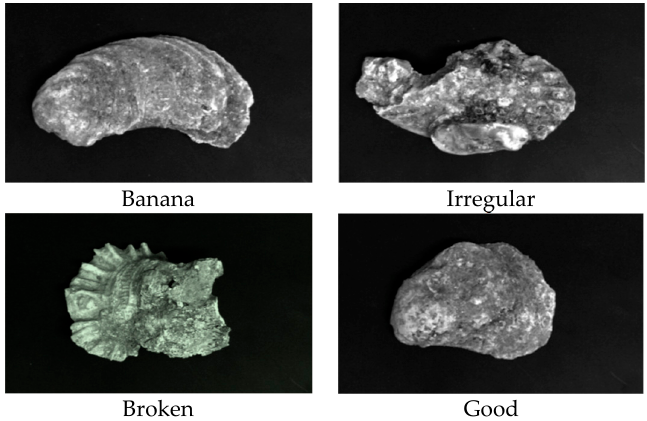
Figure 11. Image samples of the four shape categories in the oyster dataset.